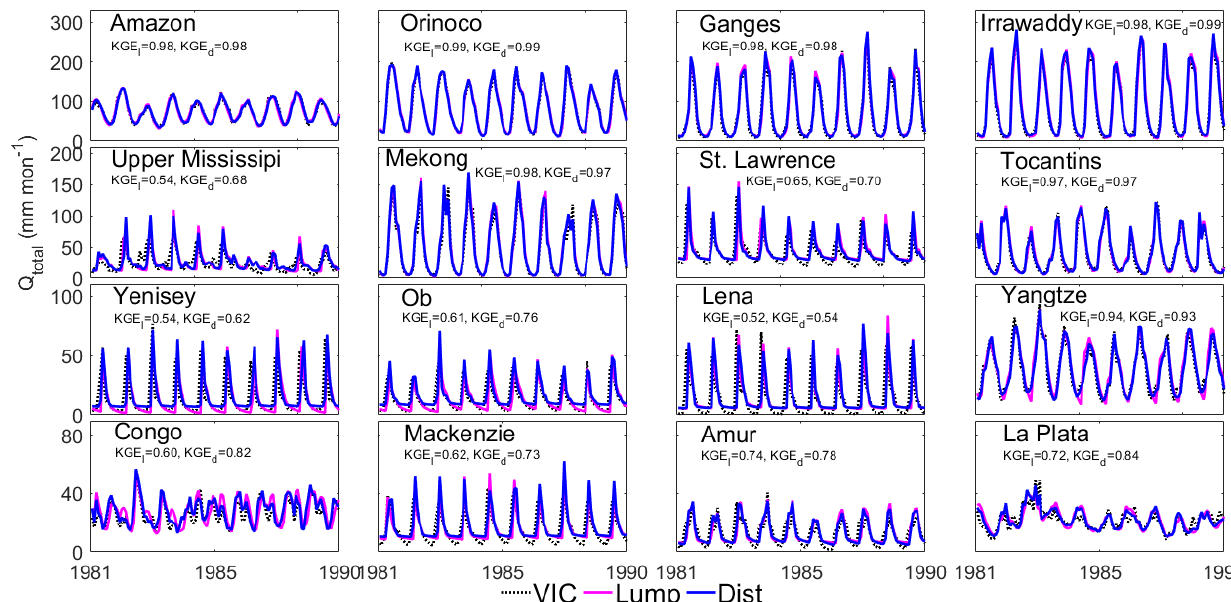
Figure 4. Time series of basin-specific total runoff ( Q total ) from the VIC product and the lumped and distributed abcd schemes for the world’s 16 river basins with top annual flow (Dai et al., 2009) during 1981–1990 (part of the calibration period 1971–1990). KGE l and KGE d stand for the KGE value for the lumped and distributed scheme,